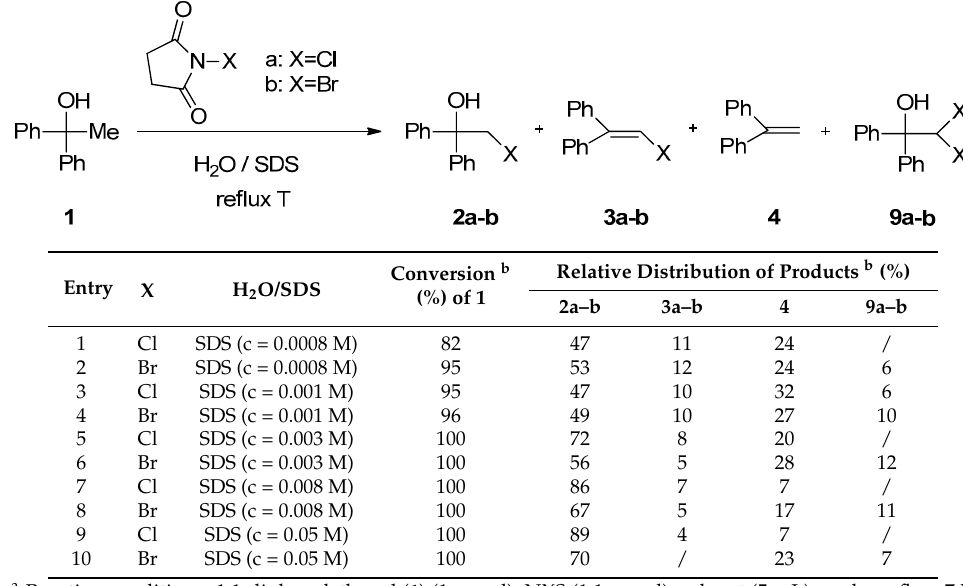
Table 3. The course of the reaction of 1,1-diphenylethanol ( 1 ) with N -halosuccinimide (NXS) in aqueous media in the presence of sodium dodecyl sulphate (SDS) amphiphile a .